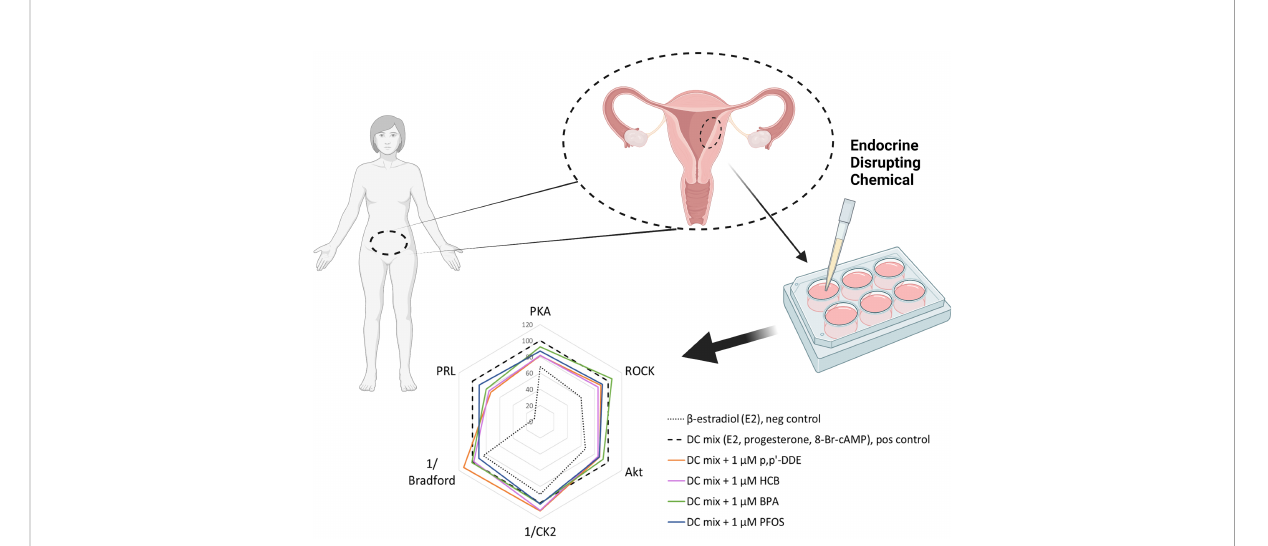
FIGURE 5 Summary of the 1 m M EDC impact on decidualization markers following in vitro treatment of ESCs. The radar plot depicts a characteristic ‘ fi ngerprint ’ of various decidualization- and viability-related markers measured in this study and the alterations caused by the presence of EDCs (as seen by shift of pattern related to that of the DC-mix). The y-axis shows normalized activities (%) of PKA, ROCK and Akt, normalized secretion (%) of prolactin (PRL), normalized reciprocal of CK2 activity (%) and normalized reciprocal of total protein content (indicated as Bradford) (%). In each case, 100% corresponds to the value measured for the decidualization mixture; the reciprocal values for CK2 activity and total protein content re fl ect the fact that these markers are reduced during decidualization. The graph summarizes data from all independent experiments performed within the study (N = 4 and n = 21 for each EDC); for better clarity, error bars are not